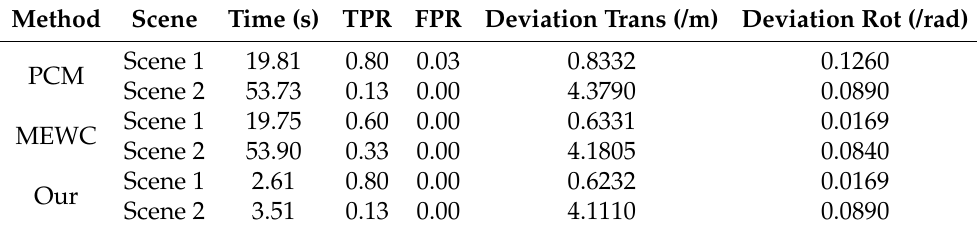
Figure 10. The fused global map corresponding to scene 2 shown in Figure 8b. Table 3. Results of real-world